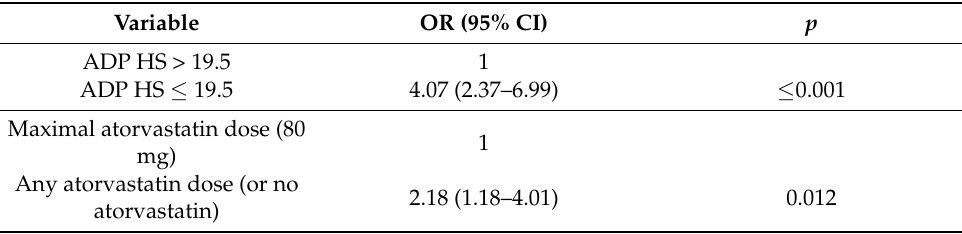
Table 6. Factors increasing the risk of